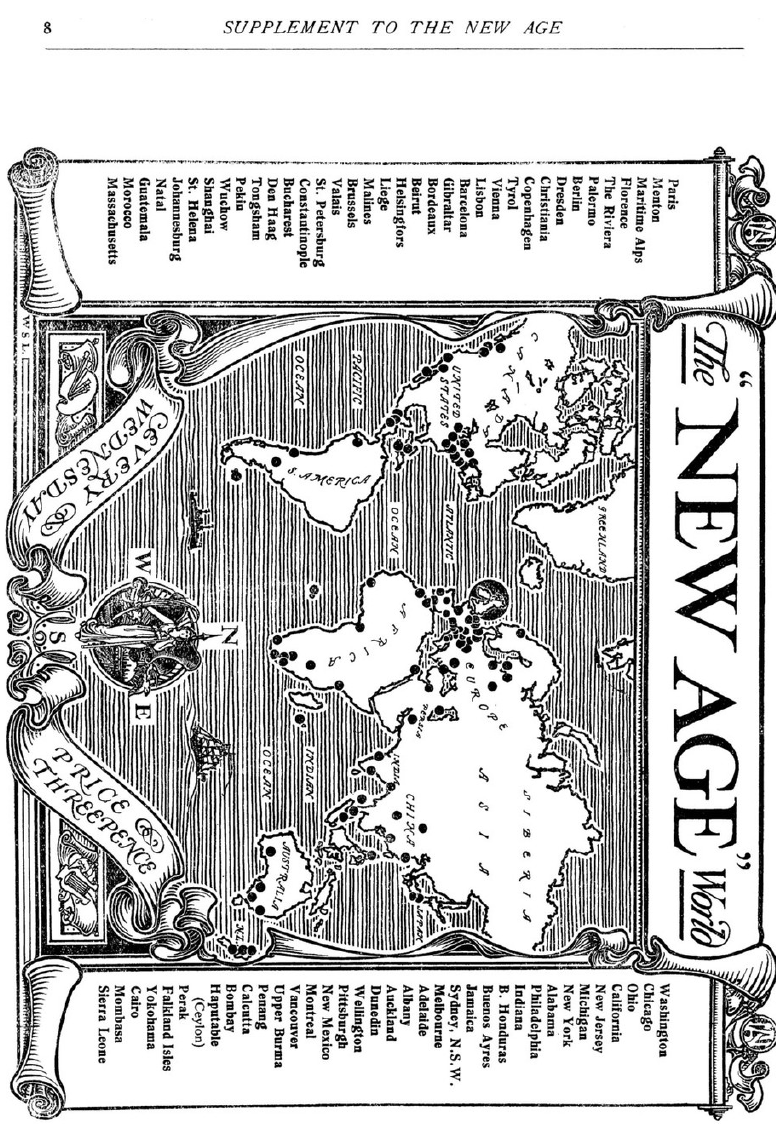
Fig. 1 New Age Distribution Map. Supplement to the New Age (3 March 1910),